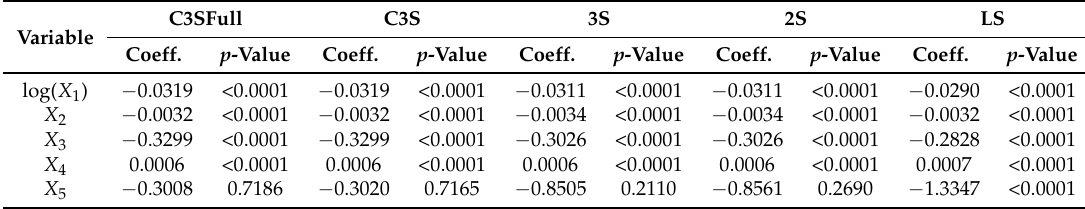
Table 7. Estimates and p-values of the regression coefficients for the airfoil self-noise data set.